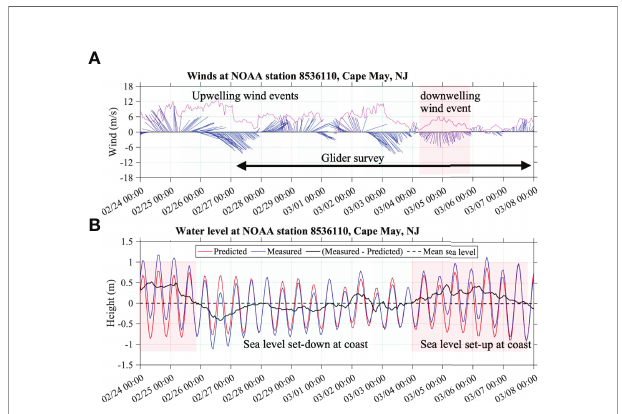
FIGURE 5 | (A) Wind and (B) water level data from the NOAA station 8536110 at Cape May, NJ (~100 km shoreward of Wilmington Canyon). For most of the time during February 25 - March 3, winds were northwesterly or southwesterly (A) , i.e. upwelling-favorable. Corresponding to the upwelling winds, the measured water level was lower than predicted, indicating a sea level set-down at the coast. Then during March 4-7, winds were northeasterly or northerly, i.e., downwelling-favorable. Corresponding to the downwelling- favorable winds, measured water level was higher than predicted, indicating a sea level set-up at the coast.